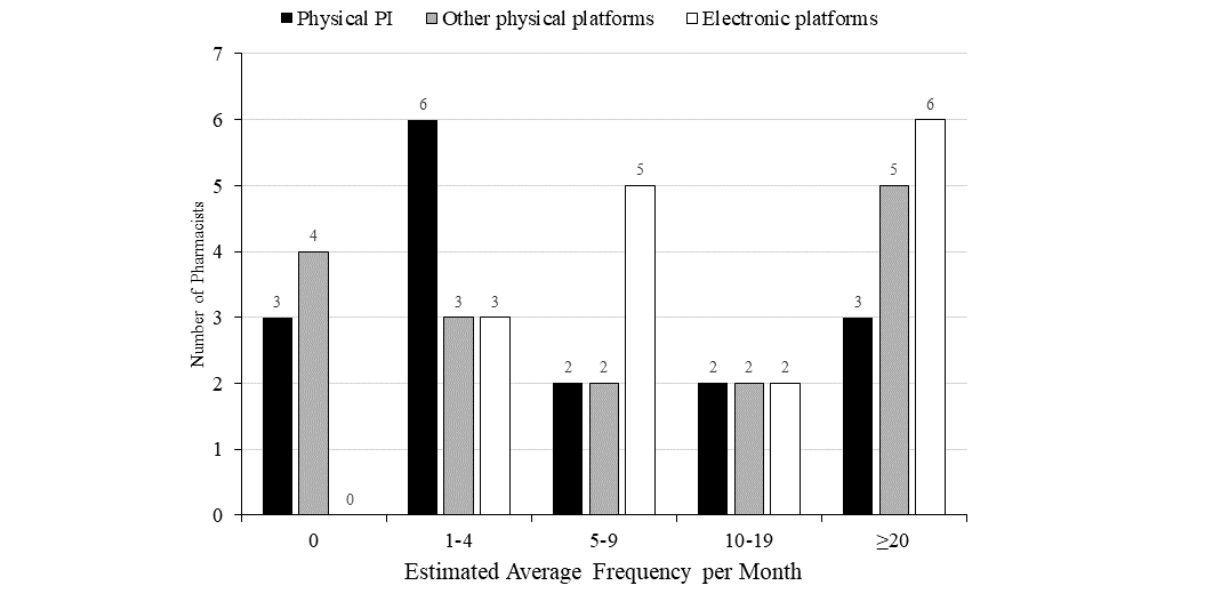
Figure 1. Frequency of retrieving drug information from different platforms (N=16). Physical PI refers to the conventional paper product information within the package of the drug product. Other physical platforms include paper copies of MIMS, BNF, LexiComp Handbook etc. Electronic platforms include electronic product information systems (eg, eMC UK, DailyMed/FDA), drug databases (eg, Lexicomp, Micromedex, AccessPharmacy), point-of-care databases (eg, ClinicalKey, UpToDate, Dynamed Plus), and Pharmaceutical (prescribing) references (eg, electronic MIMS, BNF). BNF: British National Formulary; eMC: Electronic Medicines Compendium; FDA: Food and Drug Administration; MIMS: Monthly Index of Medical Specialities; PI: product